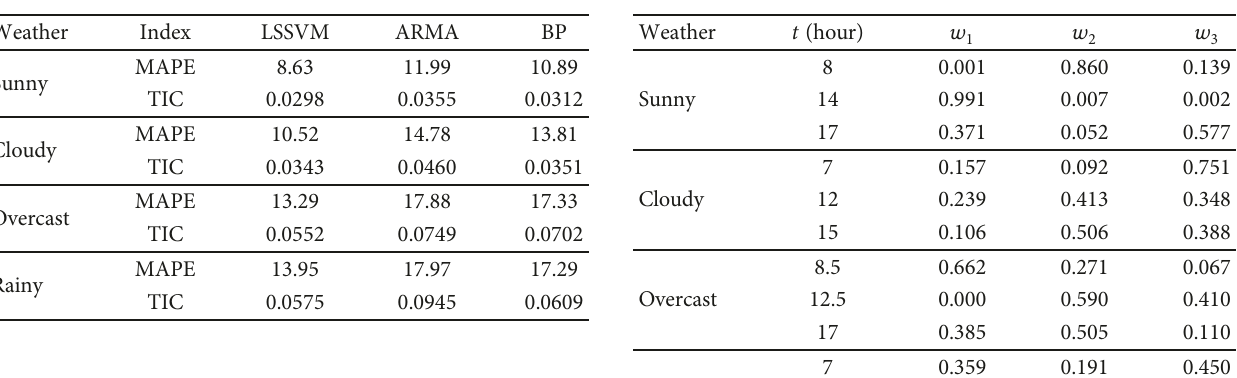
Figure 3: Forecasting results of single forecasting methods. (a) Sunny day. (b) Cloudy day. (c) Overcast day. (d) Rainy day. Table 4: Statistics of forecasting errors for single models. Table 5: Weights of cross entropy